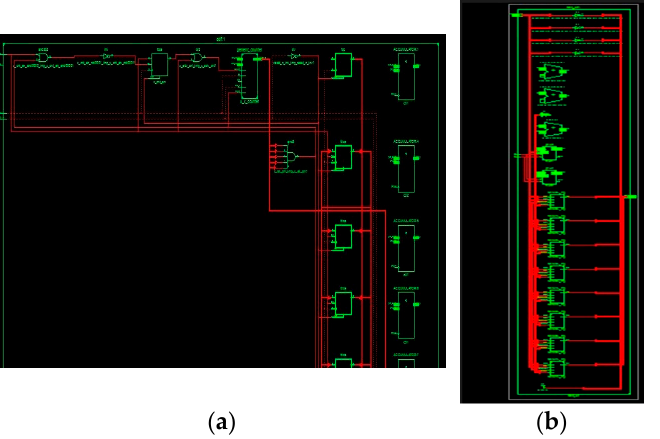
Figure 10. RTL schematic diagram of the ( a ) time-sharing single MAC ADALINE filter and ( b ) parallel MAC-based LMS.